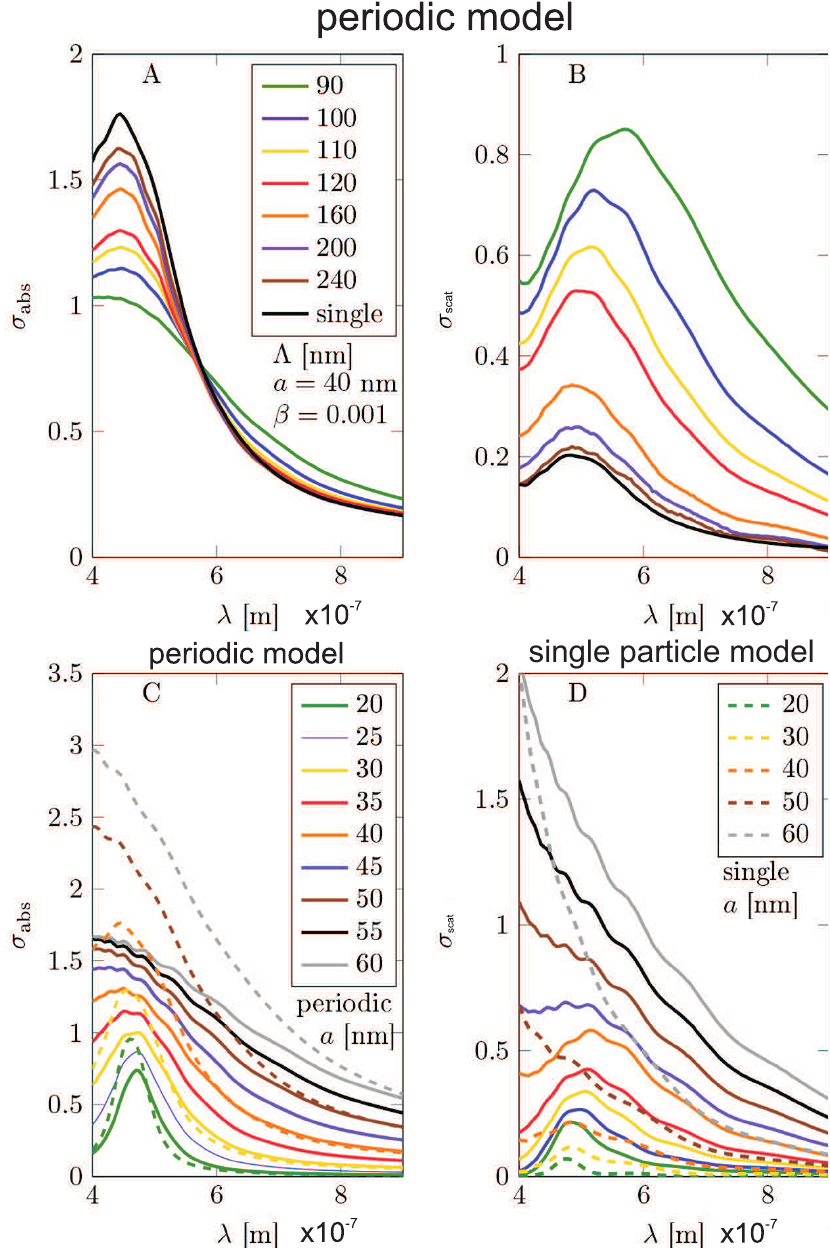
Figure 9. The periodic model—( A , C ): The absorption cross section of Au NP deposited on Si substrate as a function of the wavelength of incident electromagnetic wave for varying single cell size ( A ) and varying nanoparticle radius ( B ). ( B , D ): The scattering cross section for Au NP deposited on Si substrate; the corresponding cross sections obtained in the case of the single particle model indicated by dashed lines. ( A , B ): Results obtained from the model of periodic MNP array with constant MNP radii a = 40 nm and array period taken from the set Λ = 90, 100, 110, 120, 160, 200, 240 nm.; ( C , D ): Results obtained from the model of periodic MNP array with varying MNPs radii a = 20, 25, 30, 35, 40, 45, 50, 55, 60 nm and the array period Λ = 3 a . All the cross sections are normalized to the particle surface